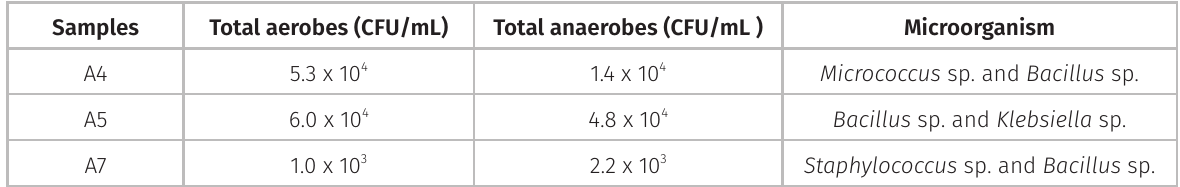
Table V. Microbiological analysis of the liquid contained in the vacuum packaging from three randomly chosen